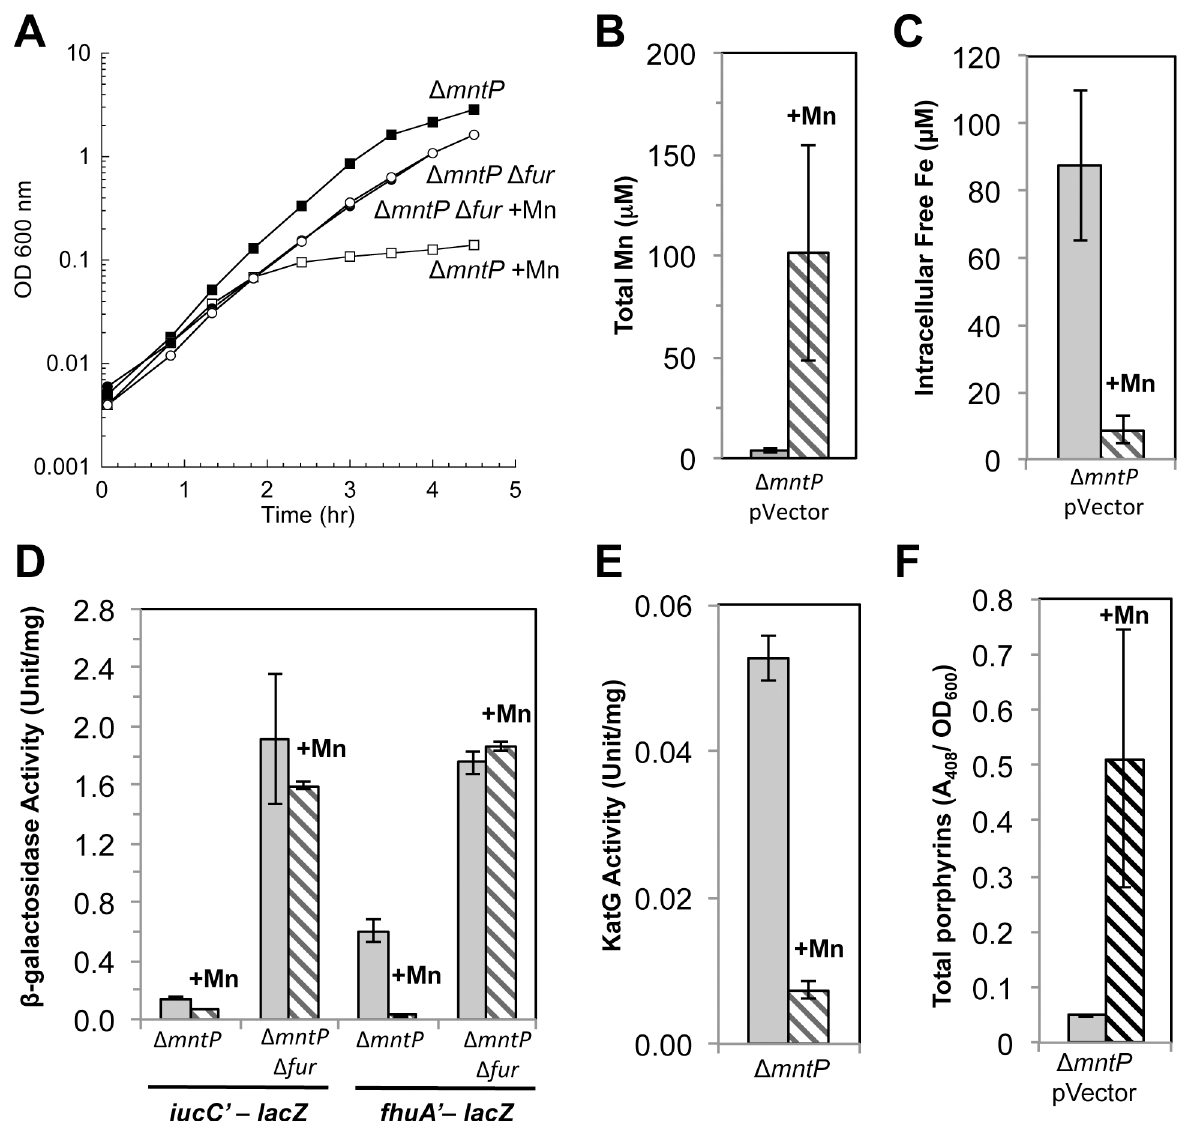
Fig 10. Lack of MntP, the manganese exporter, reproduces the phenotypes of MntS overproduction. Cells were grown in aerobic LB medium with or without 0.5 mM MnCl 2 . Metal concentrations and enzymatic activities were measured after 2.5 hr of growth. Data represent the mean of three independent cultures. A. Growth of JEM1720 ( Δ mntP ) and JEM1722 ( Δ mntP Δ fur ). B. Total intracellular manganese was determined by ICP-MS from JEM1726 ( Δ mntP